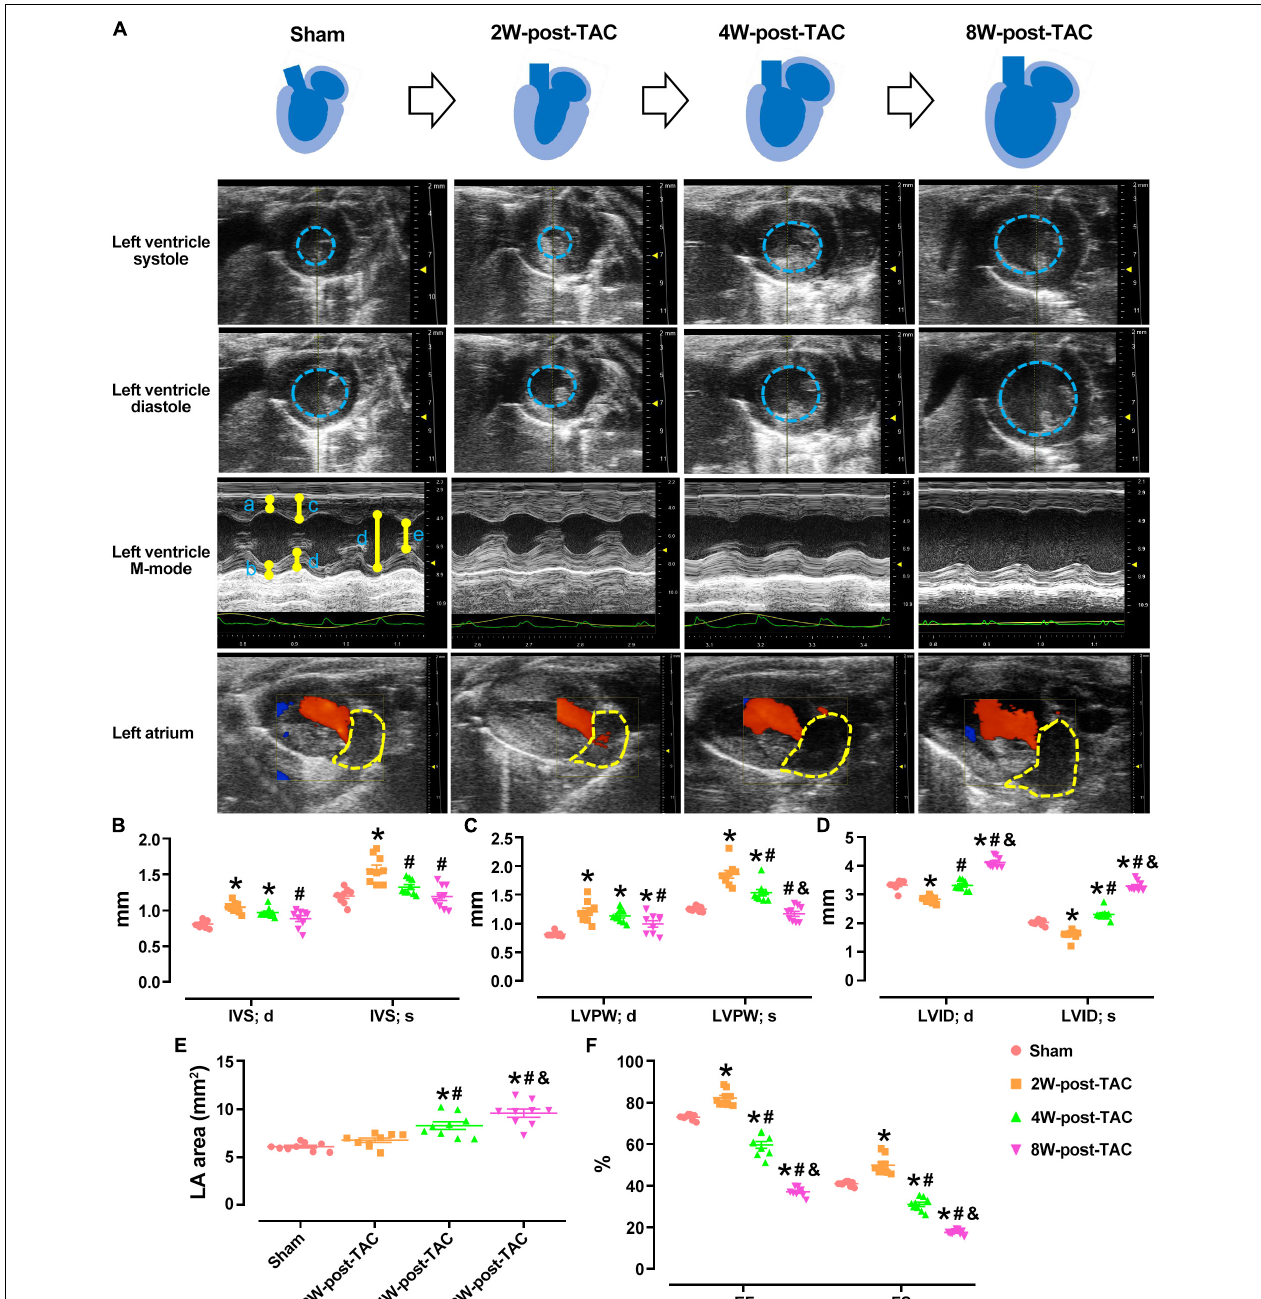
FIGURE 2 | Echocardiography of the sham and 2W-, 4W-, and 8W-post-TAC animals. The structural changes in the sham and 2W-, 4W-, and 8W-post-TAC animals were displayed in panel (A) . The heart became hypertrophic within the first 2 weeks after surgery. The thicknesses of the internal septum and posterior walls had significantly increased. After the pressure overload had continued for 4 weeks, the heart became enlarged, as indicated in the area enclosed by the blue dashed lines. The left ventricles remained enlarged and by 8W post-surgery (B,C) . The internal diameters in the 2W-post-TAC group had significantly decreased, while they had increased in the 4W-post-TAC group compared with those of the 2W-post-TAC group. The internal systolic diameters in the 8W-post-TAC group were ∼ 1.5-fold greater than those of the sham ventricles (D) . Enlargement of the left atria, as indicated in the area enclosed by the yellow dashed lines, were observed in the 4W- and 8W-post-TAC group (E) . The functional EF indices had significantly increased, preserved, and decreased in the 2W-, 4W-, and 8W-post-TAC groups, respectively (F) . All data are presented as the means ± SEM. N = 9. * P < 0.05 vs. Sham, # P < 0.05 vs. 2W-post-TAC, and & P < 0.05 vs. 4W-post-TAC.